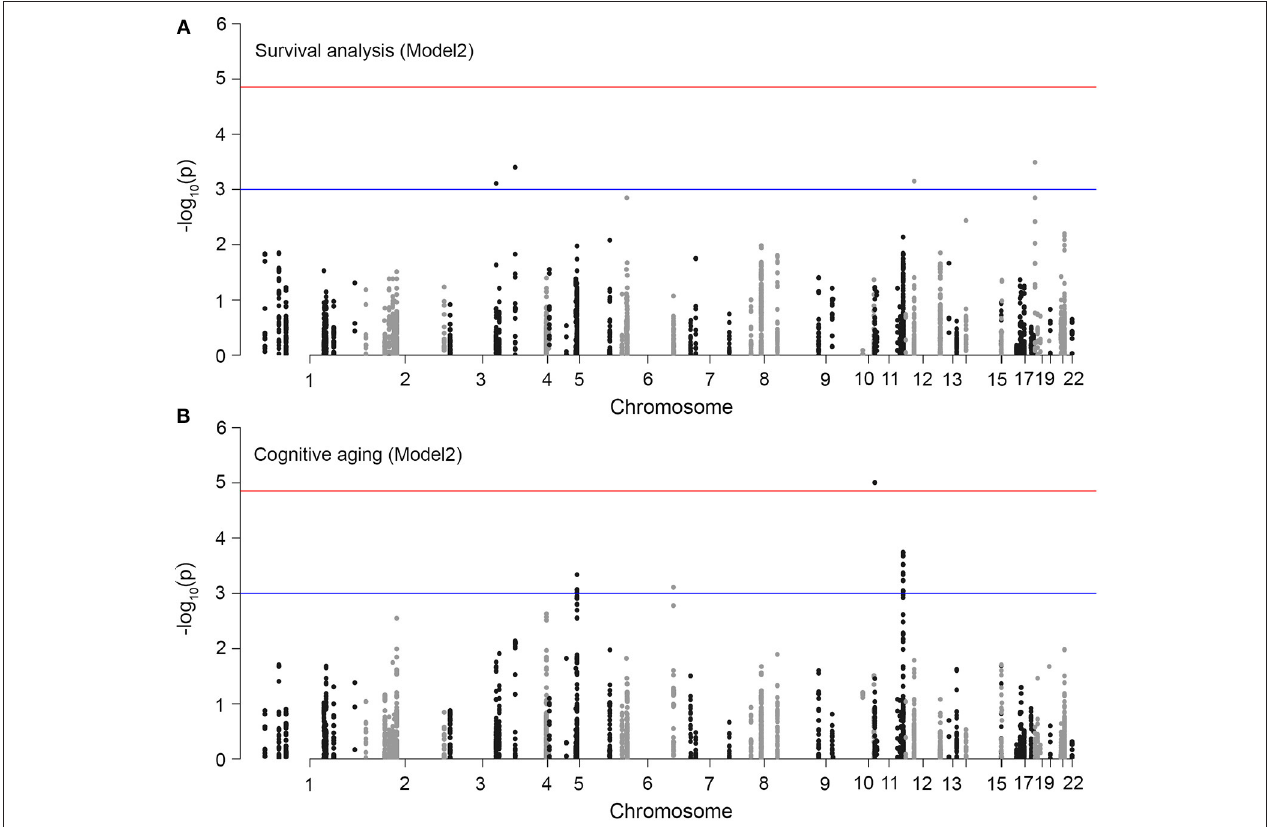
FIGURE 3 | Association plots for aging traits in WHIMS. Each point in the plots represents a variant in an MRP gene (total number of markers = 3,693). The chromosomal position is on the x-axis and the y-axis shows the − log 10 ( p -value) of association with (A) survival time, and (B) cognitive aging. The top horizontal red line denotes the multiple-test corrected significant p -value threshold (1.3 × 10 − 5 ). We set a suggestive threshold of 1 × 10 − 3 (denoted by bottom blue